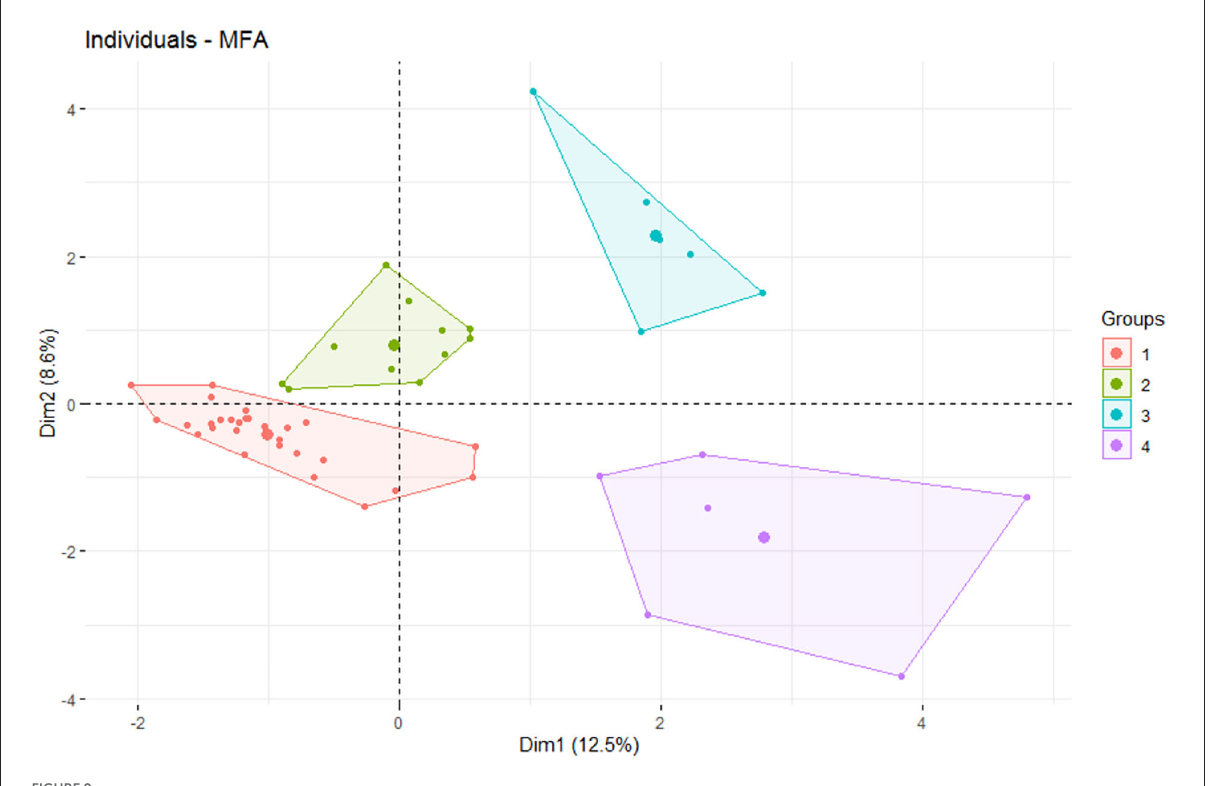
FIGURE9 Clustering of women.